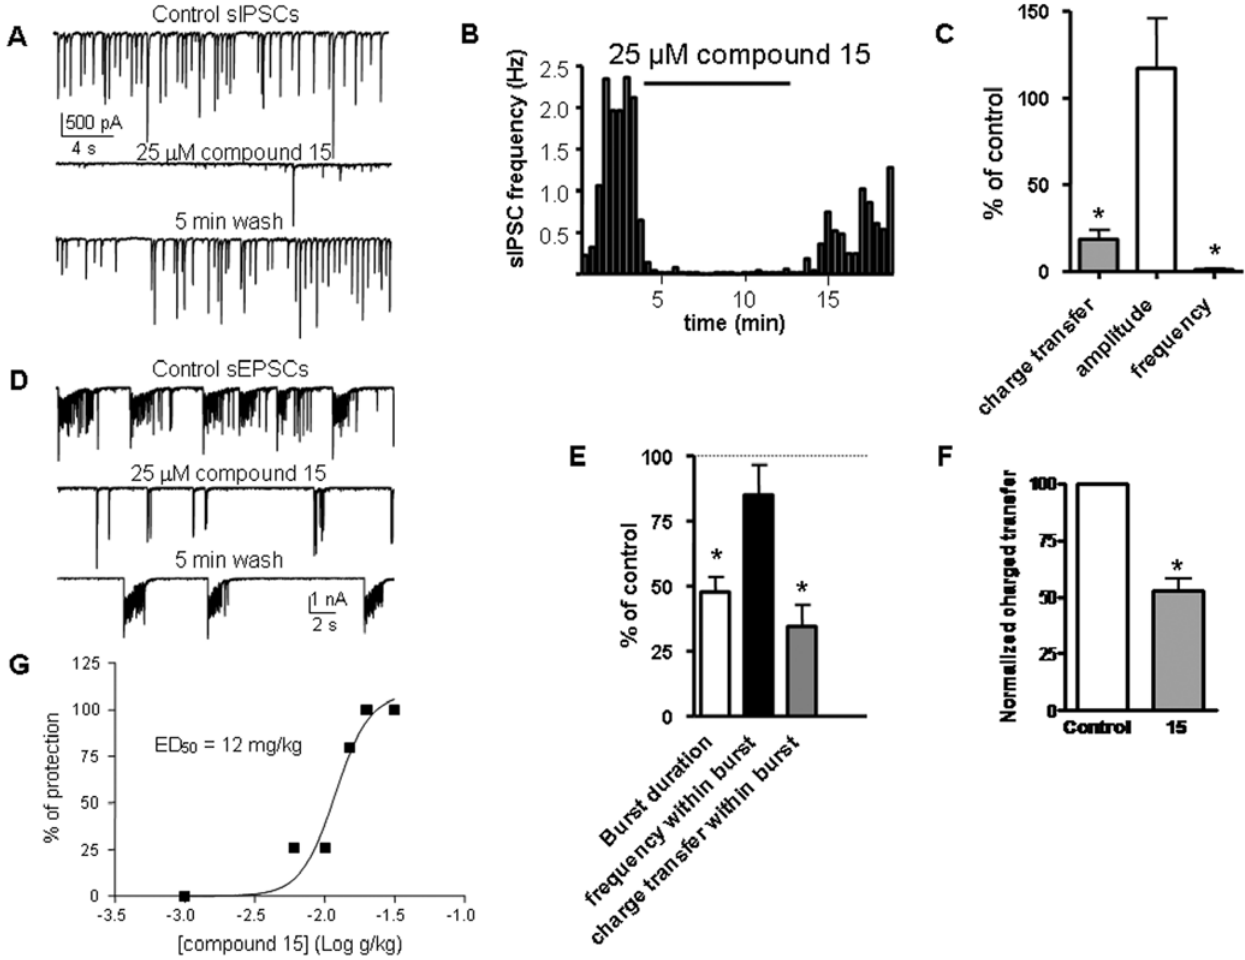
Figure 8. Effects of compound 15 on spontaneous glutamate and GABA release and on maximal electroshock seizure model in mice. (A) Representative traces of spontaneous IPSCs recorded at a holding potential of 2 70 mV, before (control), during exposure to 25 m M compound 15 and after washout (wash). (B) Representative experiment showing sIPSCs frequency as a function of time, before, during exposure to 25 m M compound 15 and after washout. (C) Effect of 25 m M compound 15 on normalized charge transfer, amplitude and frequency of sIPSCs (n=7; * p , 0.01). (D) Representative traces of spontaneous EPSCs recorded at a holding potential of 2 70 mV, before (control), during exposure to 25 m M compound 15 and after washout (wash). (E) effect of 25 m M compound 15 on normalized burst duration, on frequency and charge transfer within bursts and on total (F) charge transfer of sEPSCs (n=6; * p , 0.01). (G) Compound 15 protects from epileptic seizures induced by the MES generalized epilepsy model in mice (0.2 sec, 50 mA) with ED 50 of 12